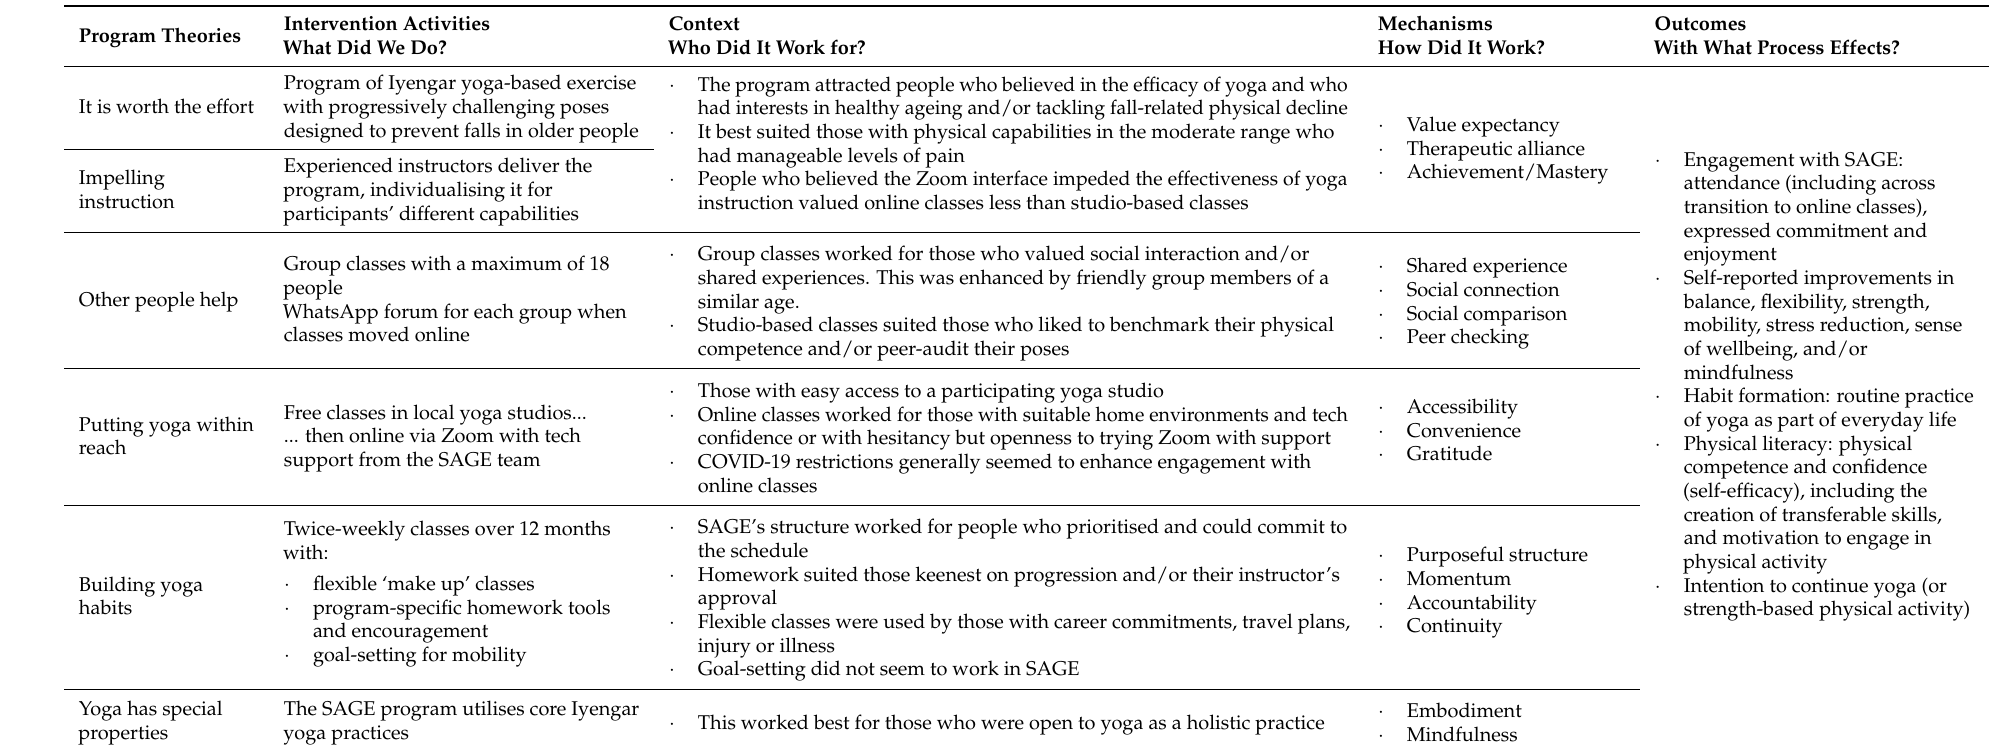
Table 4. An overview of how the hybrid SAGE yoga program worked for current